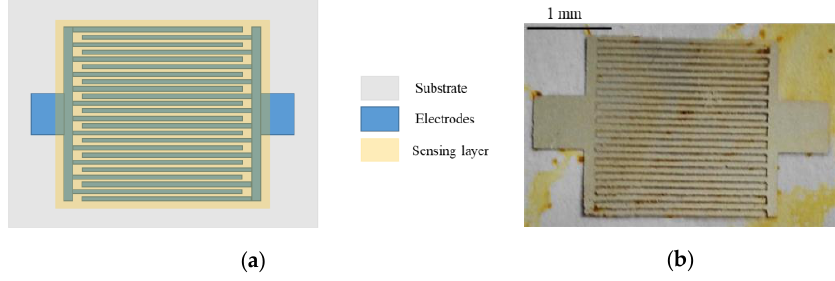
Figure 1. Schematic of the sensor ( a ) and real picture ( b ).